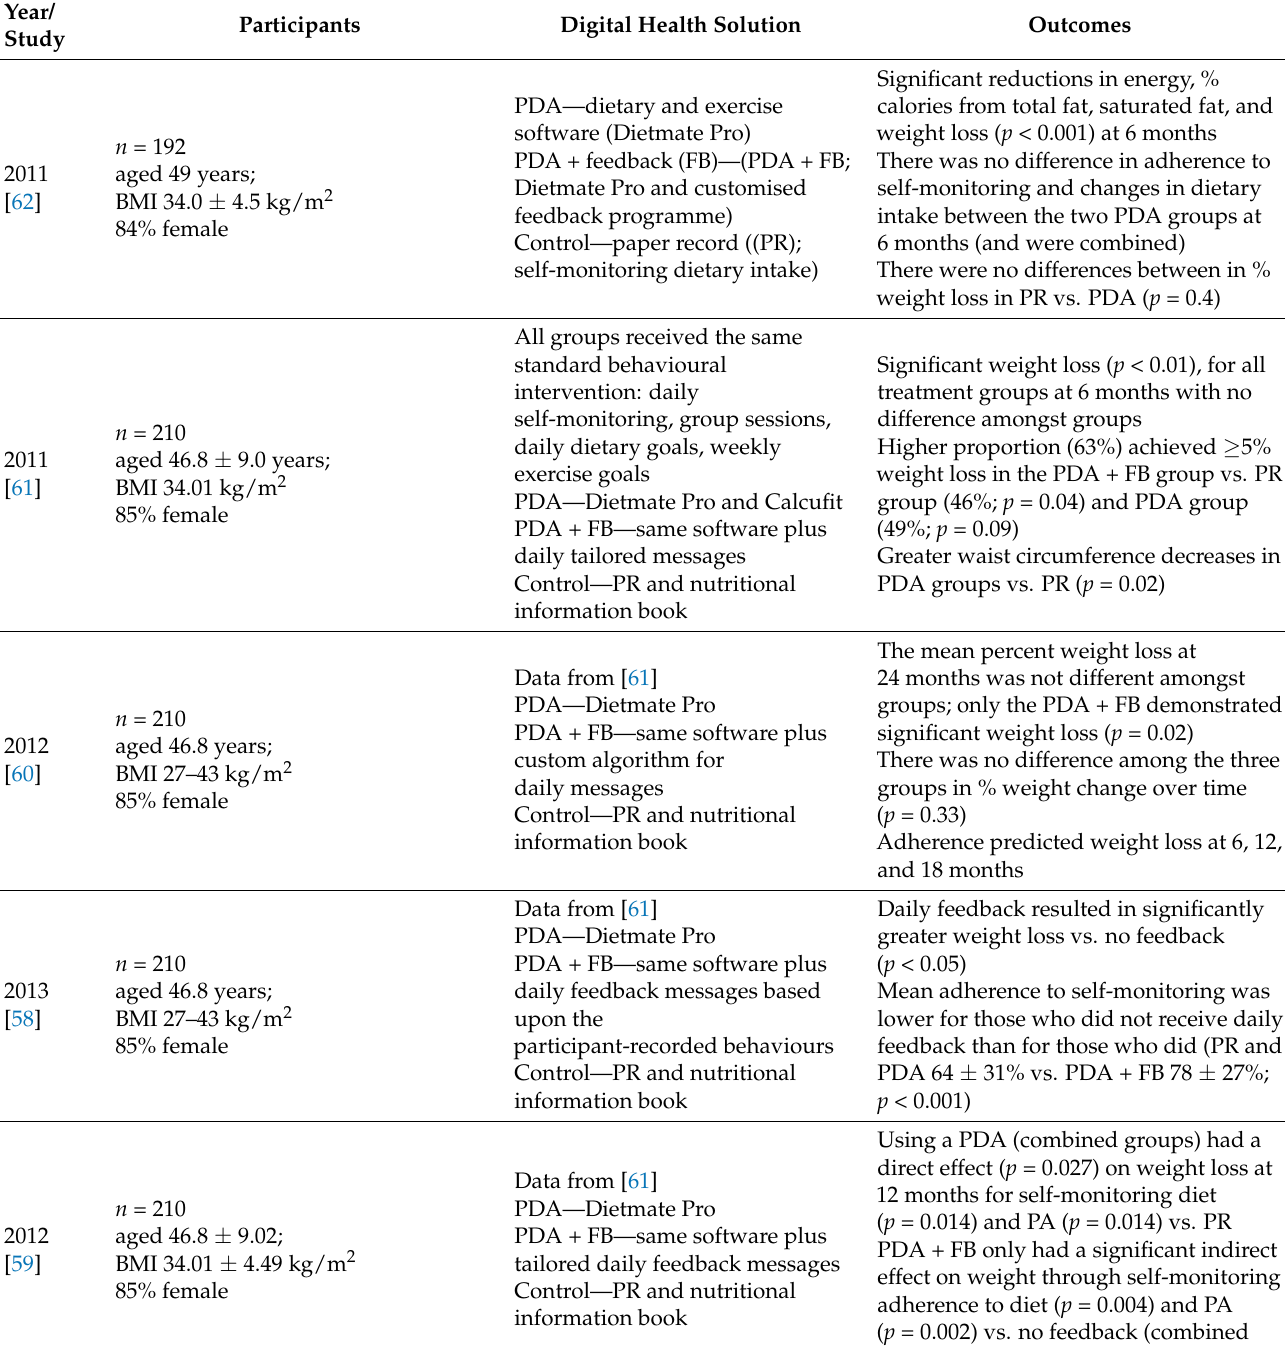
Table 2. Study characteristics for the use of a